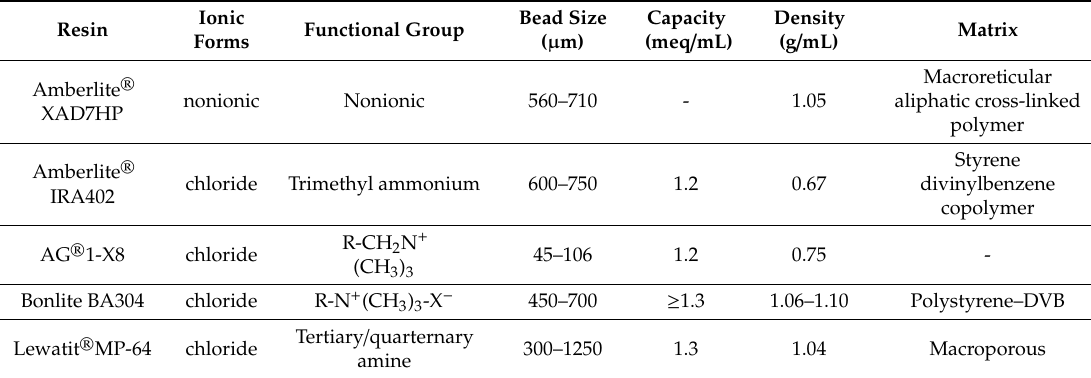
Table 1. Physical properties of the resins used in this